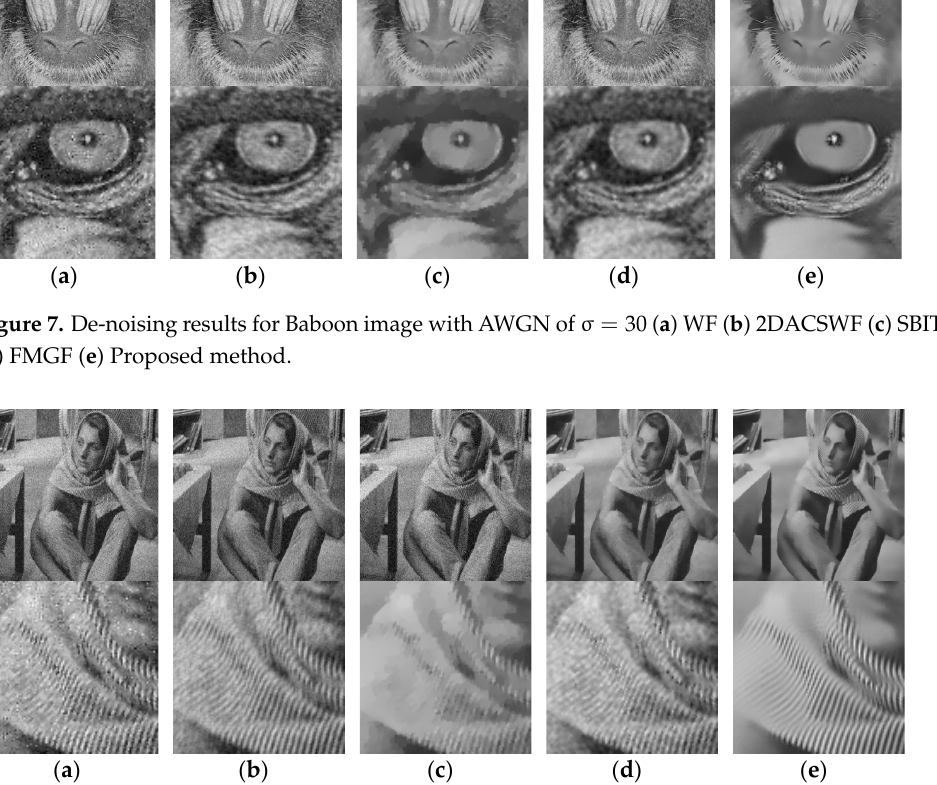
Figure 8. De-noising results for Barbara image with AWGN of σ = 30 ( a ) WF ( b ) 2DACSWF ( c ) SBITV ( d ) FMGF ( e ) Proposed method.